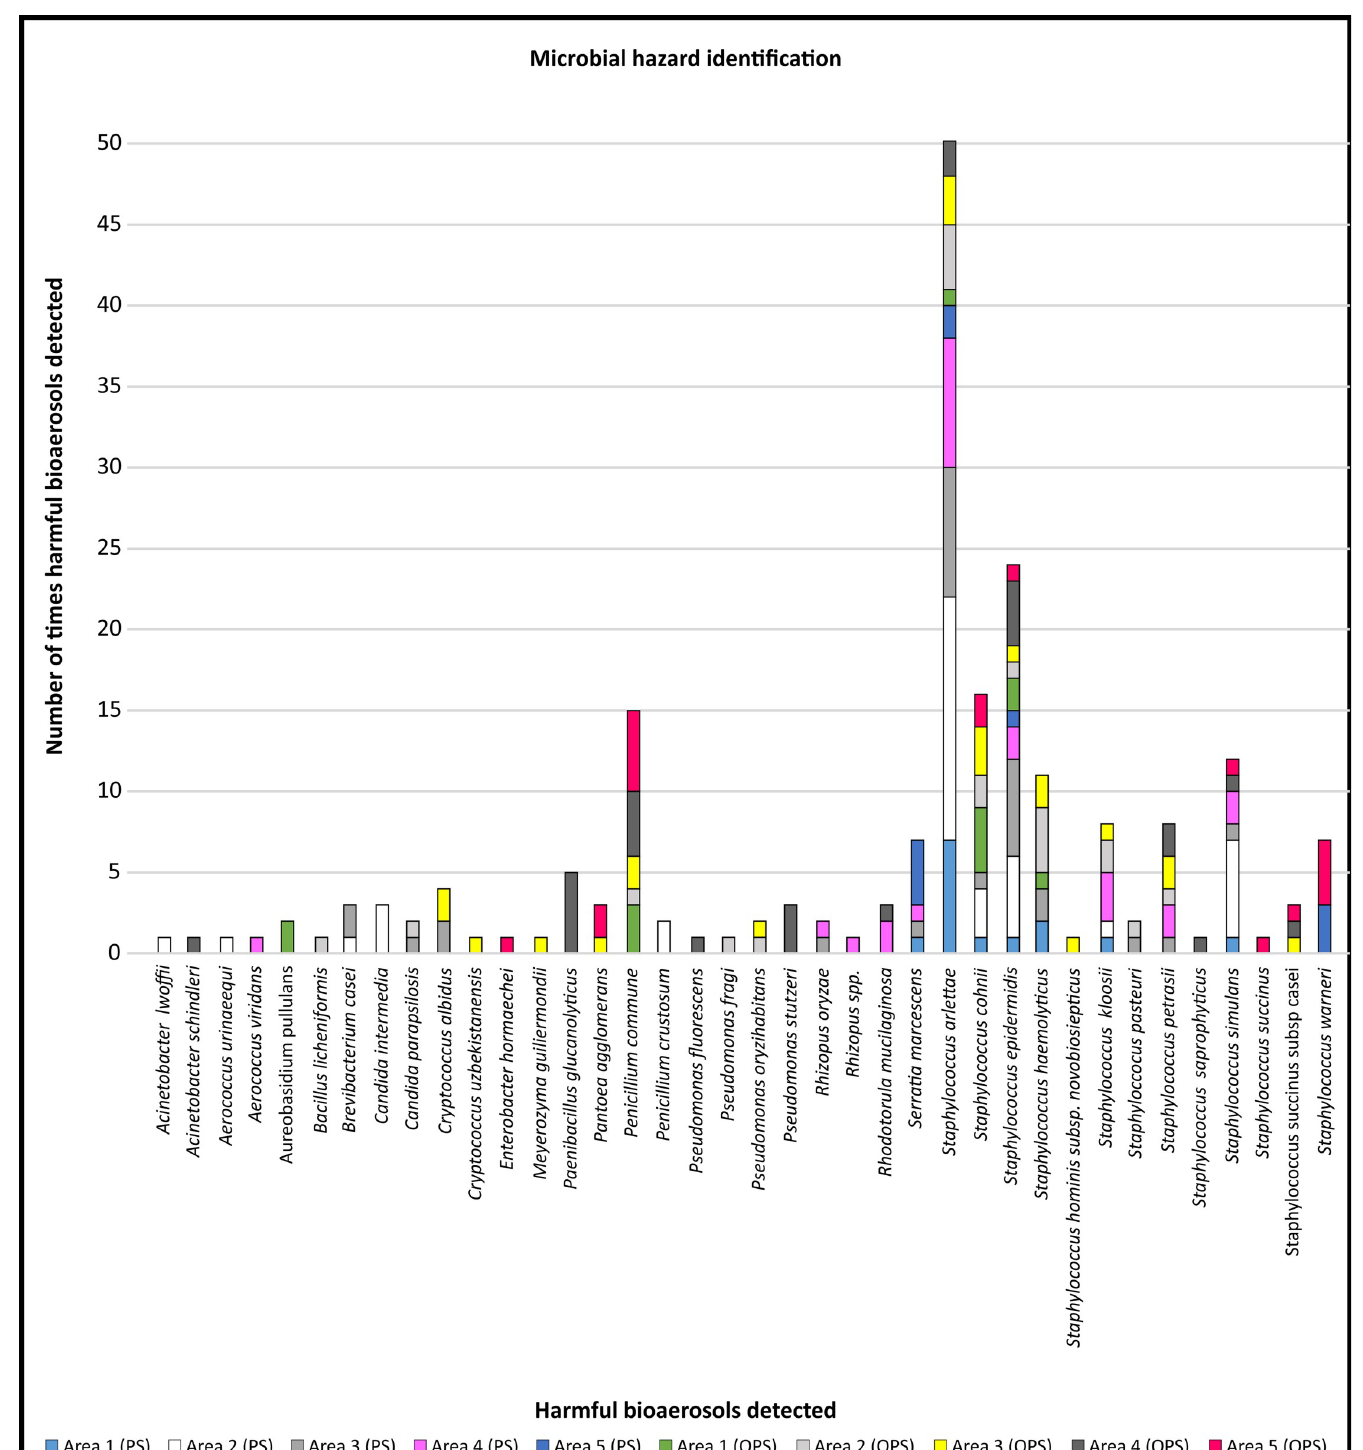
Fig 4. Microbial hazard identification. Number of identified harmful bioaerosols detected during the two sampling seasons in the designated areas: entrance to the production area (Area 1), preparation and mixing of materials (Area 2), between the production lines (Area 3), dispersion of bottles (Area 4) and filling of the final product (Area 5). The two sampling phases are indicated as peak season (PS) (onset of summer) and off-peak season (OPS) (onset of autumn).